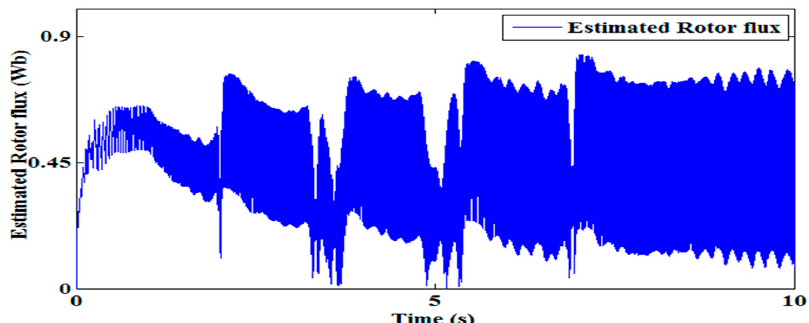
Figure 9. Estimated rotor flux of SMLO 1.